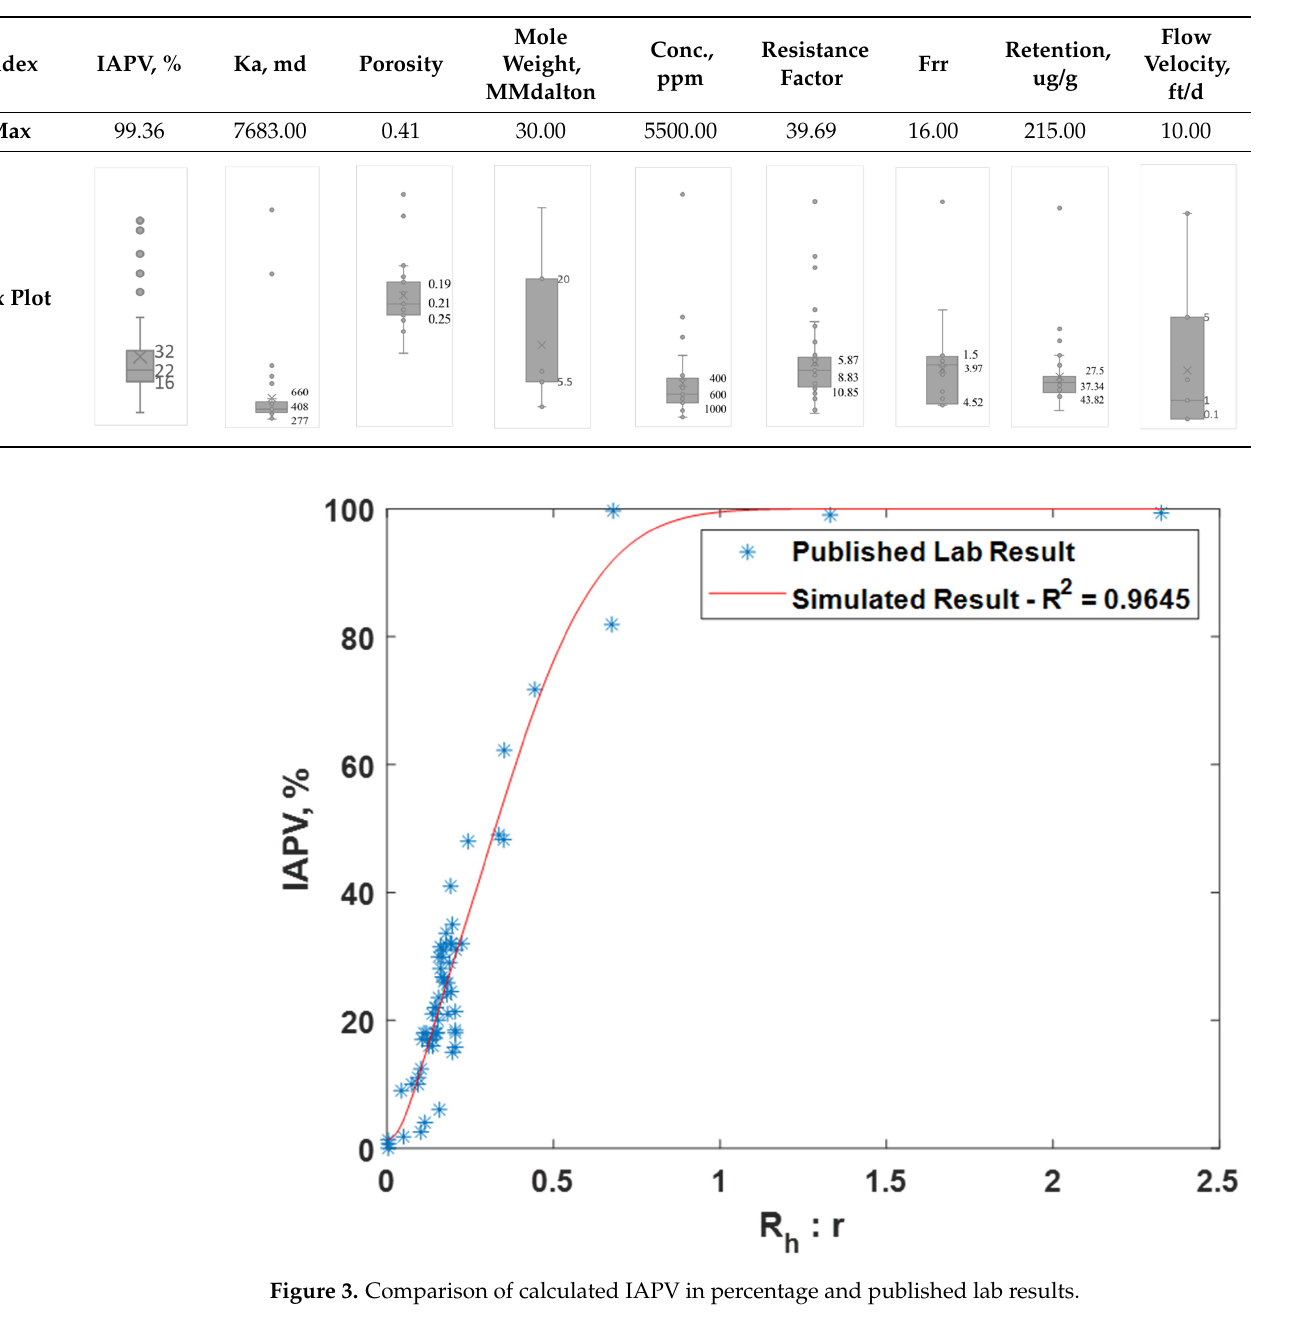
Table 1. The descriptive information of the collected data.